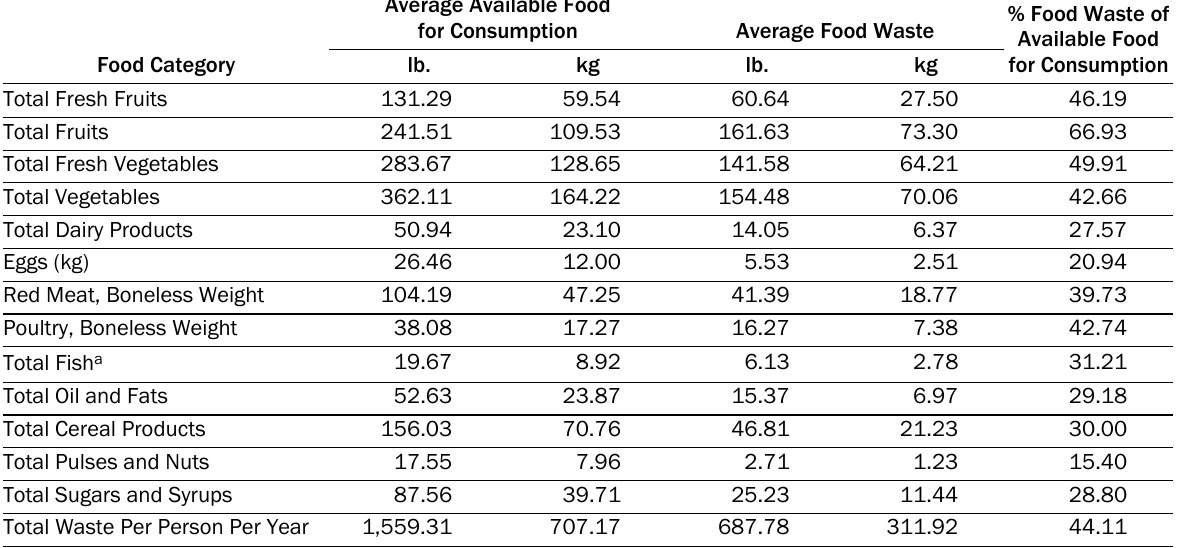
Table 1. Average Available Food for Consumption, Average Waste, and Percentage of Food Waste of Available Food for Consumption by Food Category